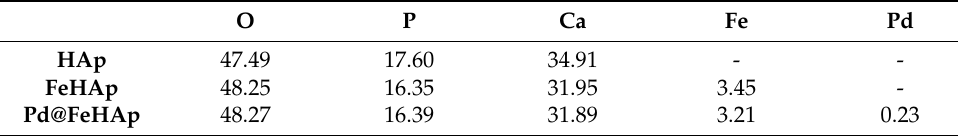
Figure 1. ( a ) XRD patterns and ( b ) Raman spectra of HAp, FeHAp, and Pd@FeHAp. Table 2. Elemental composition (%wt) of HAp, FeHAp, and